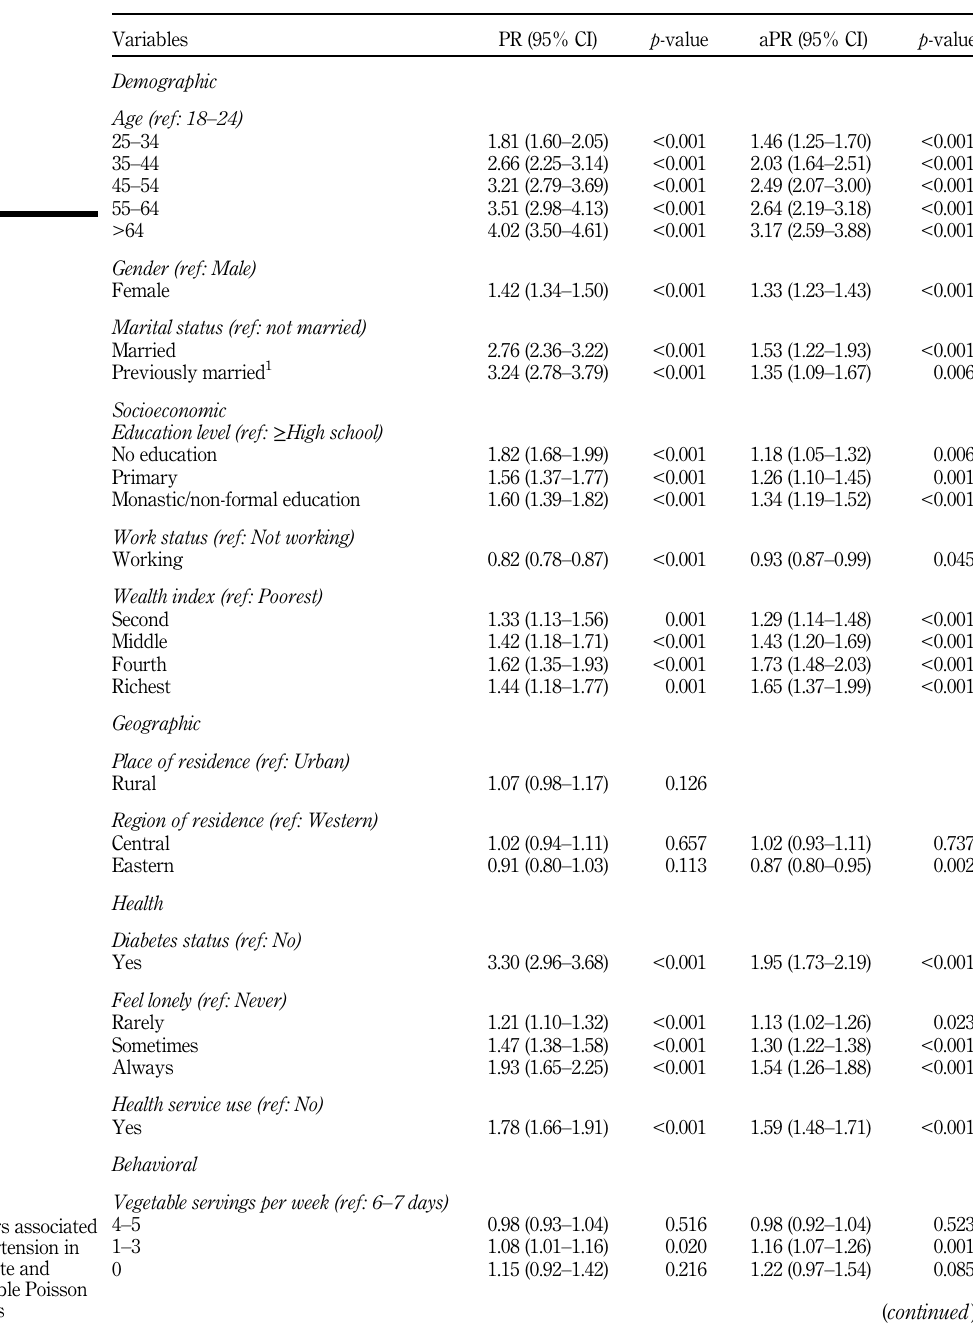
Table 2. Risk factors associated with hypertension in the bivariate and multivariable Poisson